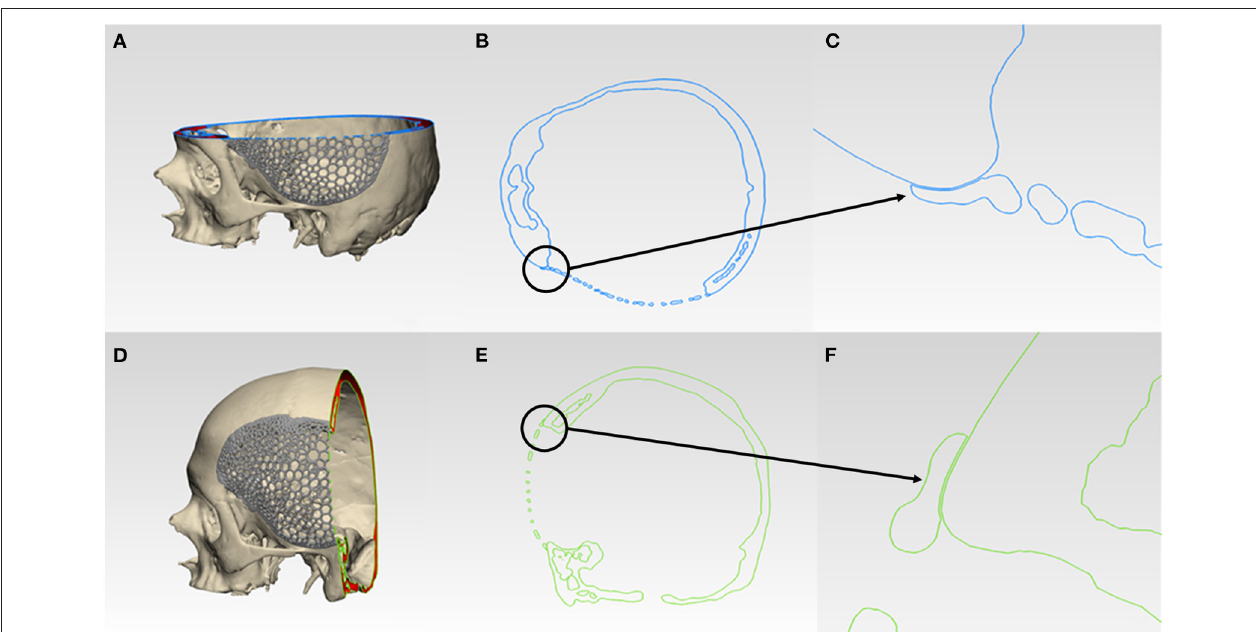
FIGURE 7 | Virtual morphological fit and contour continuity analysis of organic Voronoi pattern customized cranial prosthesis. (A) Cutting plane in the Z-direction (blue). (B) Cross-sectional analysis along the z-axis. (C) Magnified view of the cross-sectional analysis along the z-axis. (D) Cutting plane in the Y-direction (green). (E) Cross-sectional analysis along the y-axis. (F) Magnified view of the cross-sectional analysis along the